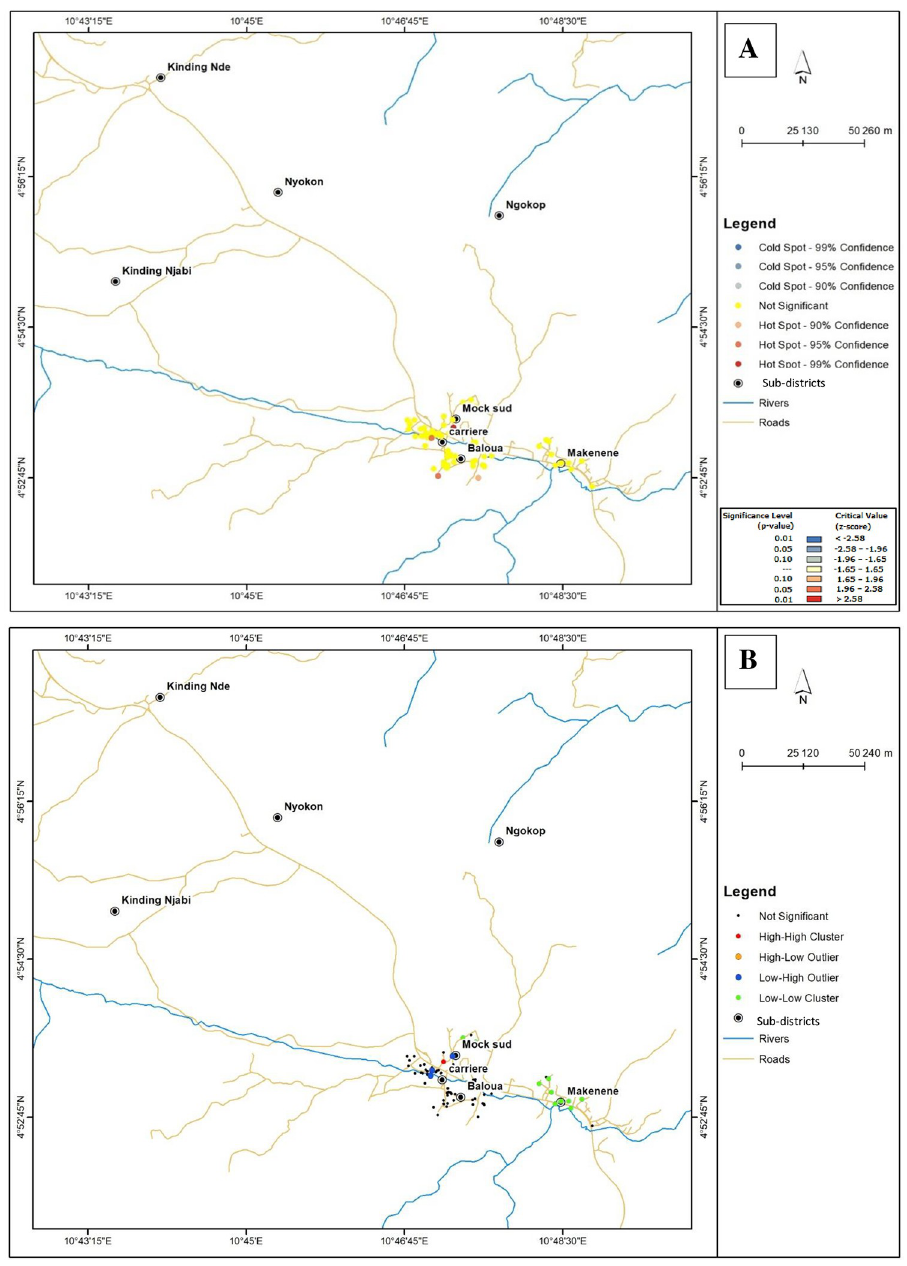
Fig 7. Global and Local Moran’s I cluster maps showing S . mansoni infection intensities inferred from KK (base layer of the maps were obtained using a free online spatial data software (https://www.diva-gis.org/gdata). High-high cluster indicates significant ( p < 0.05) clustering (hot-spot) of houses of children carrying heavy infection intensities of S . mansoni ; low-low cluster indicates significant ( p < 0.05) clustering (cold spot) of houses of children carrying light infection intensities of S . mansoni ; low-high outlier indicates areas where houses of children carrying heavy infection intensities were surrounded by those of children carrying light or moderate infection intensities; high-low outlier indicates areas where houses of children carrying light infection intensities were surrounded by those of children carrying heavy infection